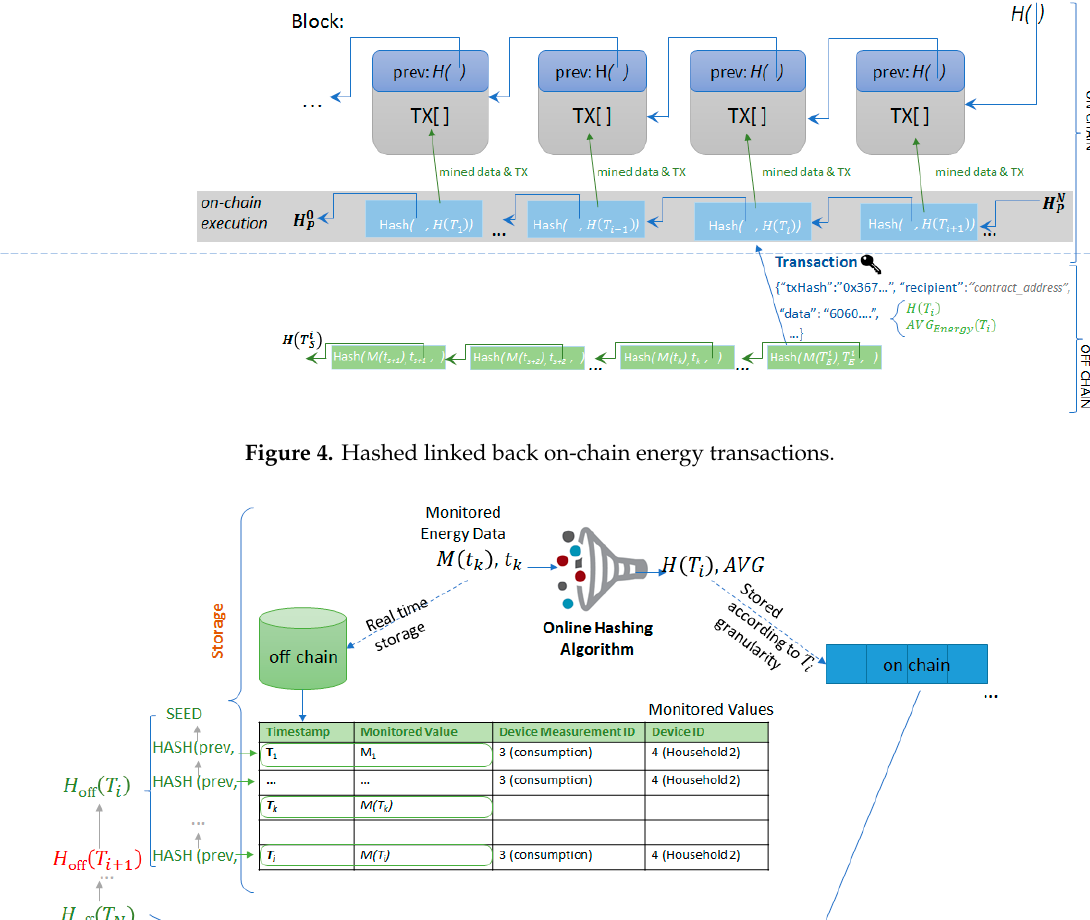
Figure 4. Hashed linked back on-chain energy transactions.